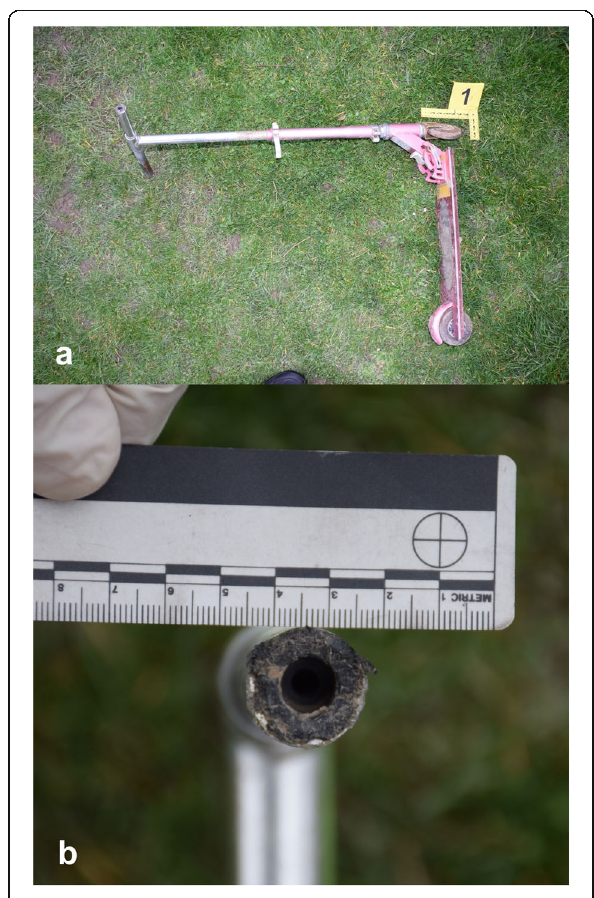
Fig. 2 Display of the children ’ s scooter during the crime scene investigation ( a ) and of the scooter handlebar (initially suspected cause of injury) ( b